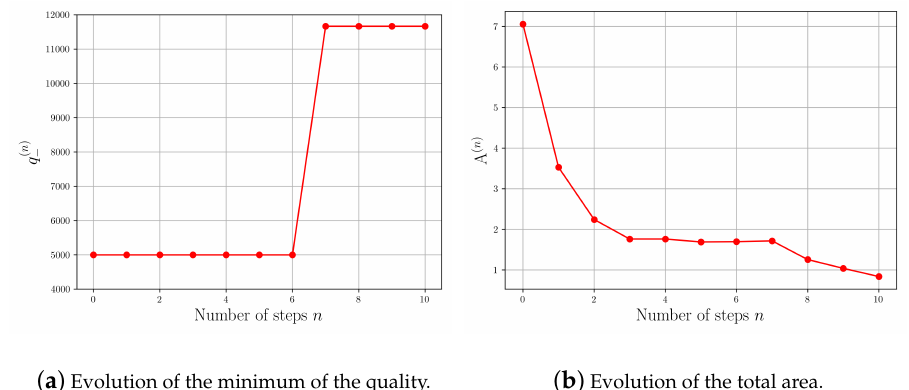
( a ) Evolution of the minimum of the quality. ( b ) Evolution of the total area. Figure 11. Evolution of the minimum of the quality and the total area as function of the iteration count, n